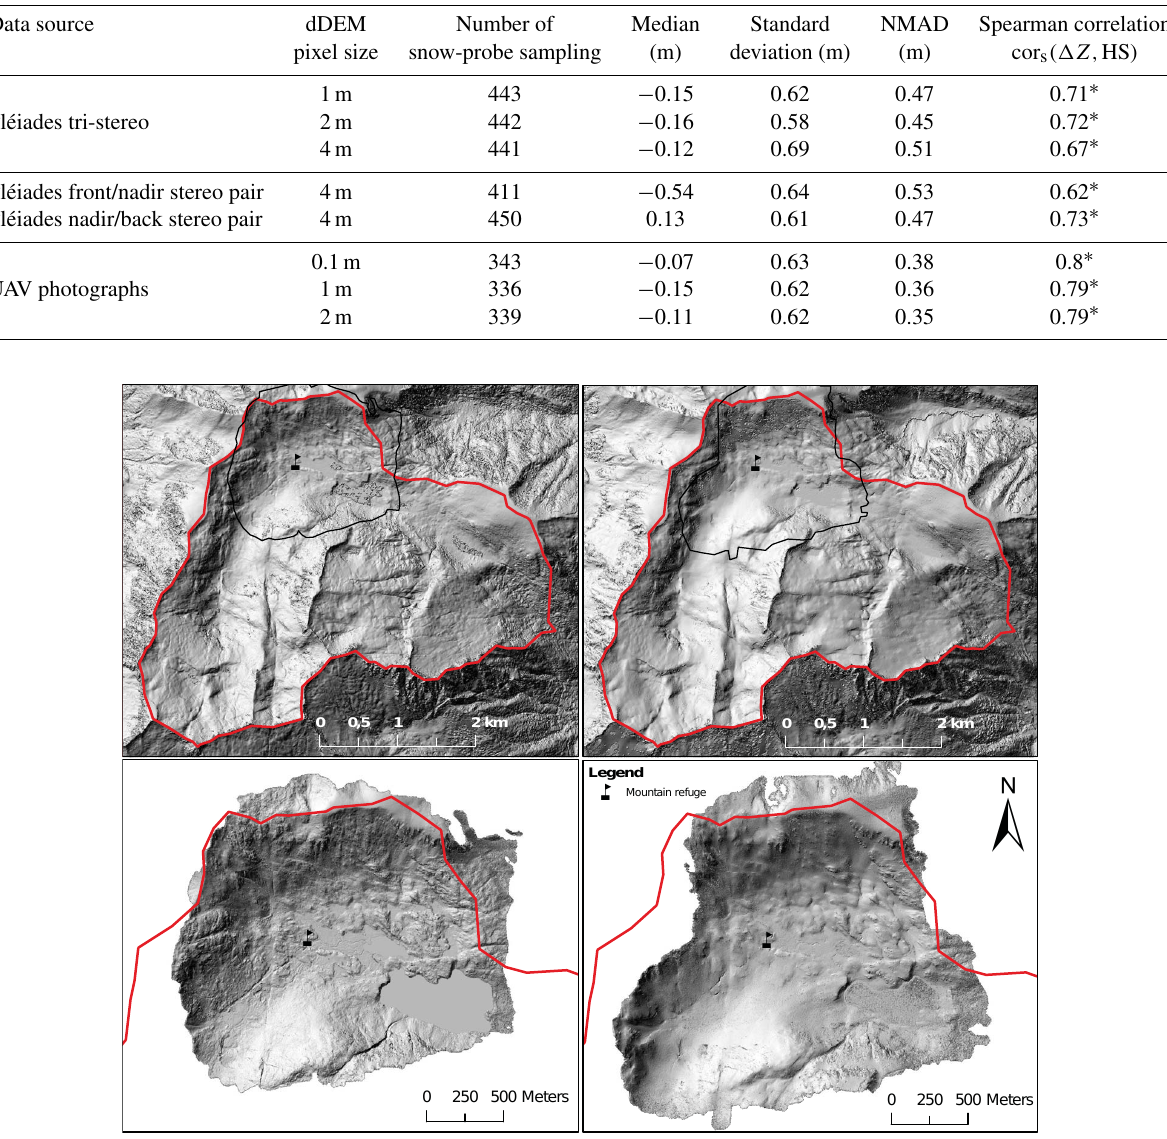
Figure 5. Hillshade of snow-free 2m Pléiades (top left) and 1m UAV (bottom left) DEMs and winter 2m Pléiades (top right) and 1m UAV (bottom right) DEMs. The outlines of the UAV extents are indicated in the Pléiades